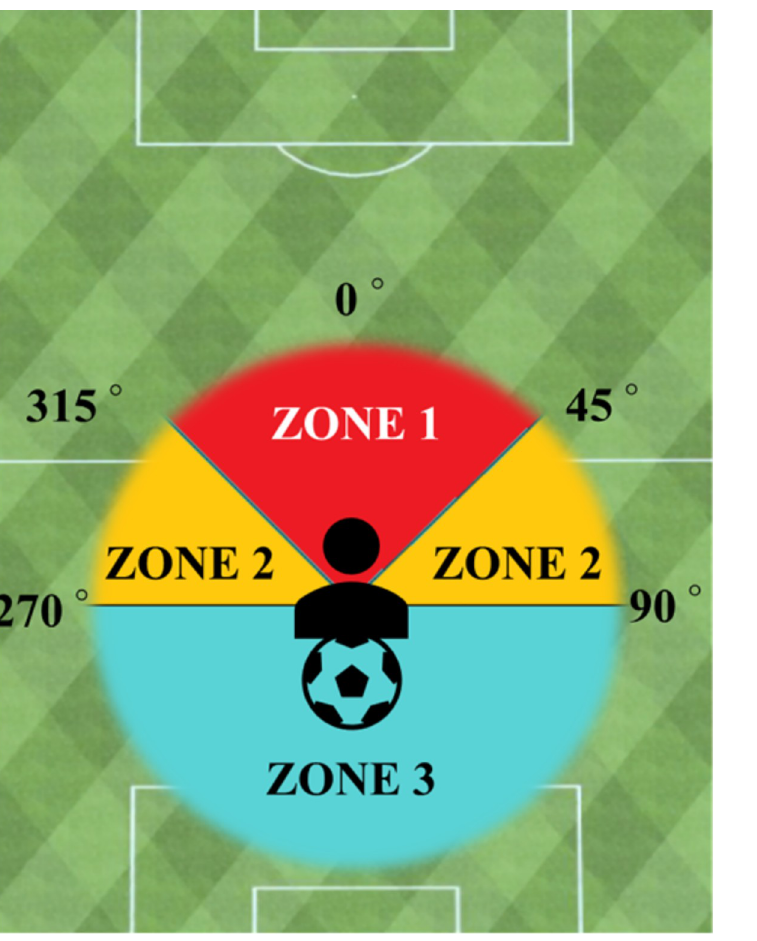
Fig 1. Zonal division of the visual exploratory